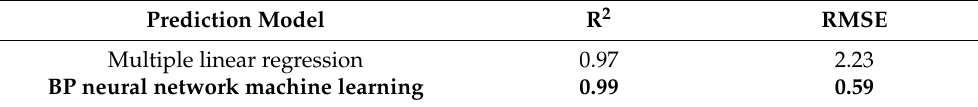
Table 9. Comparison of prediction models for wheat moisture content at maturity stage.